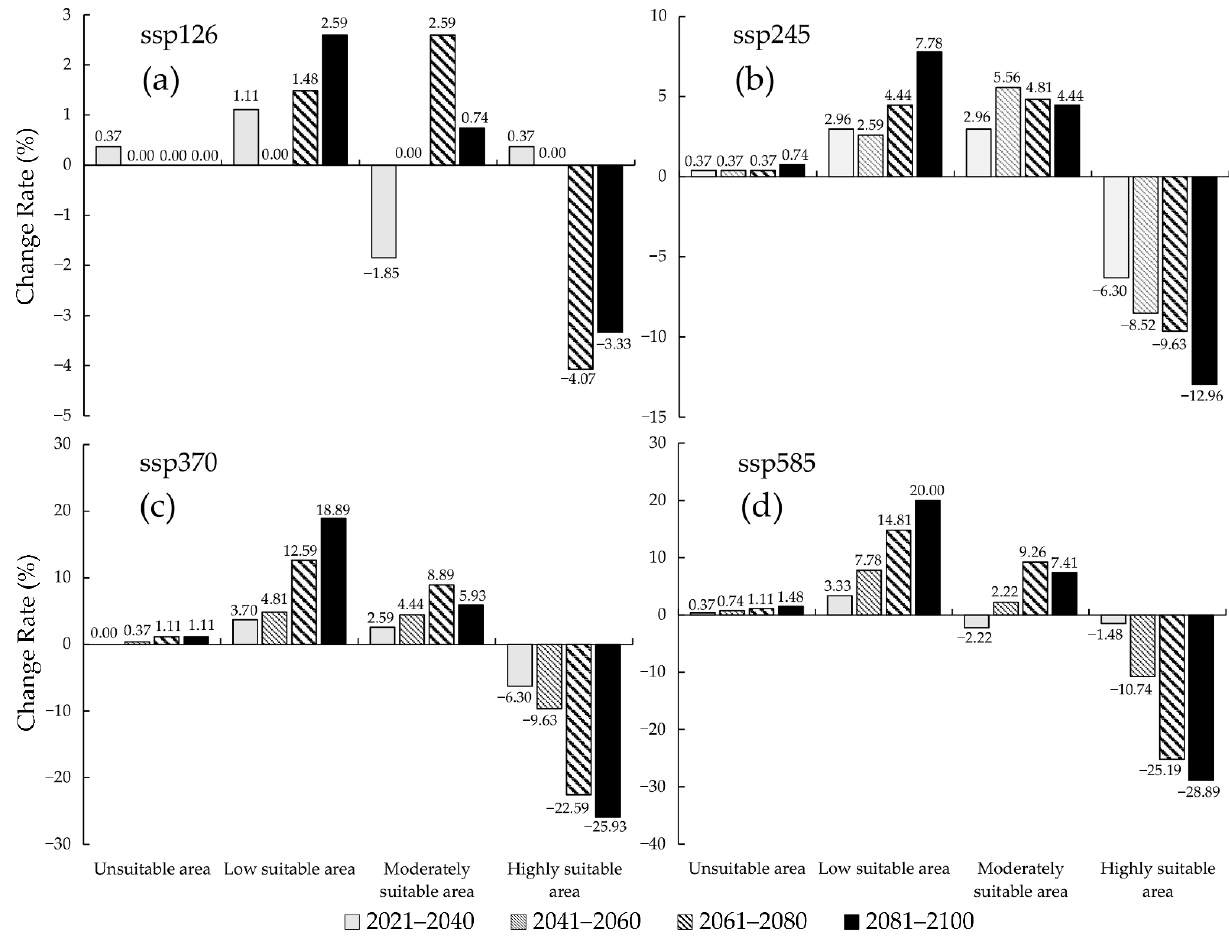
Figure 9. The change rate of predicted potential distribution of S. juvencus around the world under the future climate conditions during the periods of the 21st century under four CMIP6 climate scenarios, compared with the number of occurrence points under near current climate conditions and four shared socio-economic pathways: ( a ) ssp126; ( b ) ssp245; ( c ) ssp370; ( d ) ssp585.